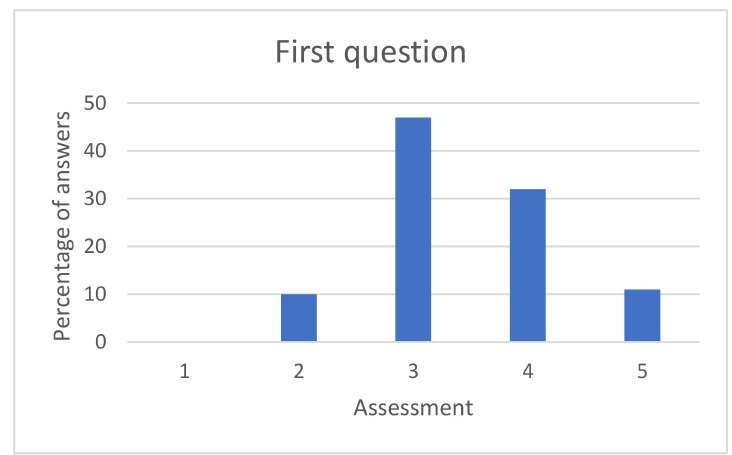
Figure A2. Results of question 1.